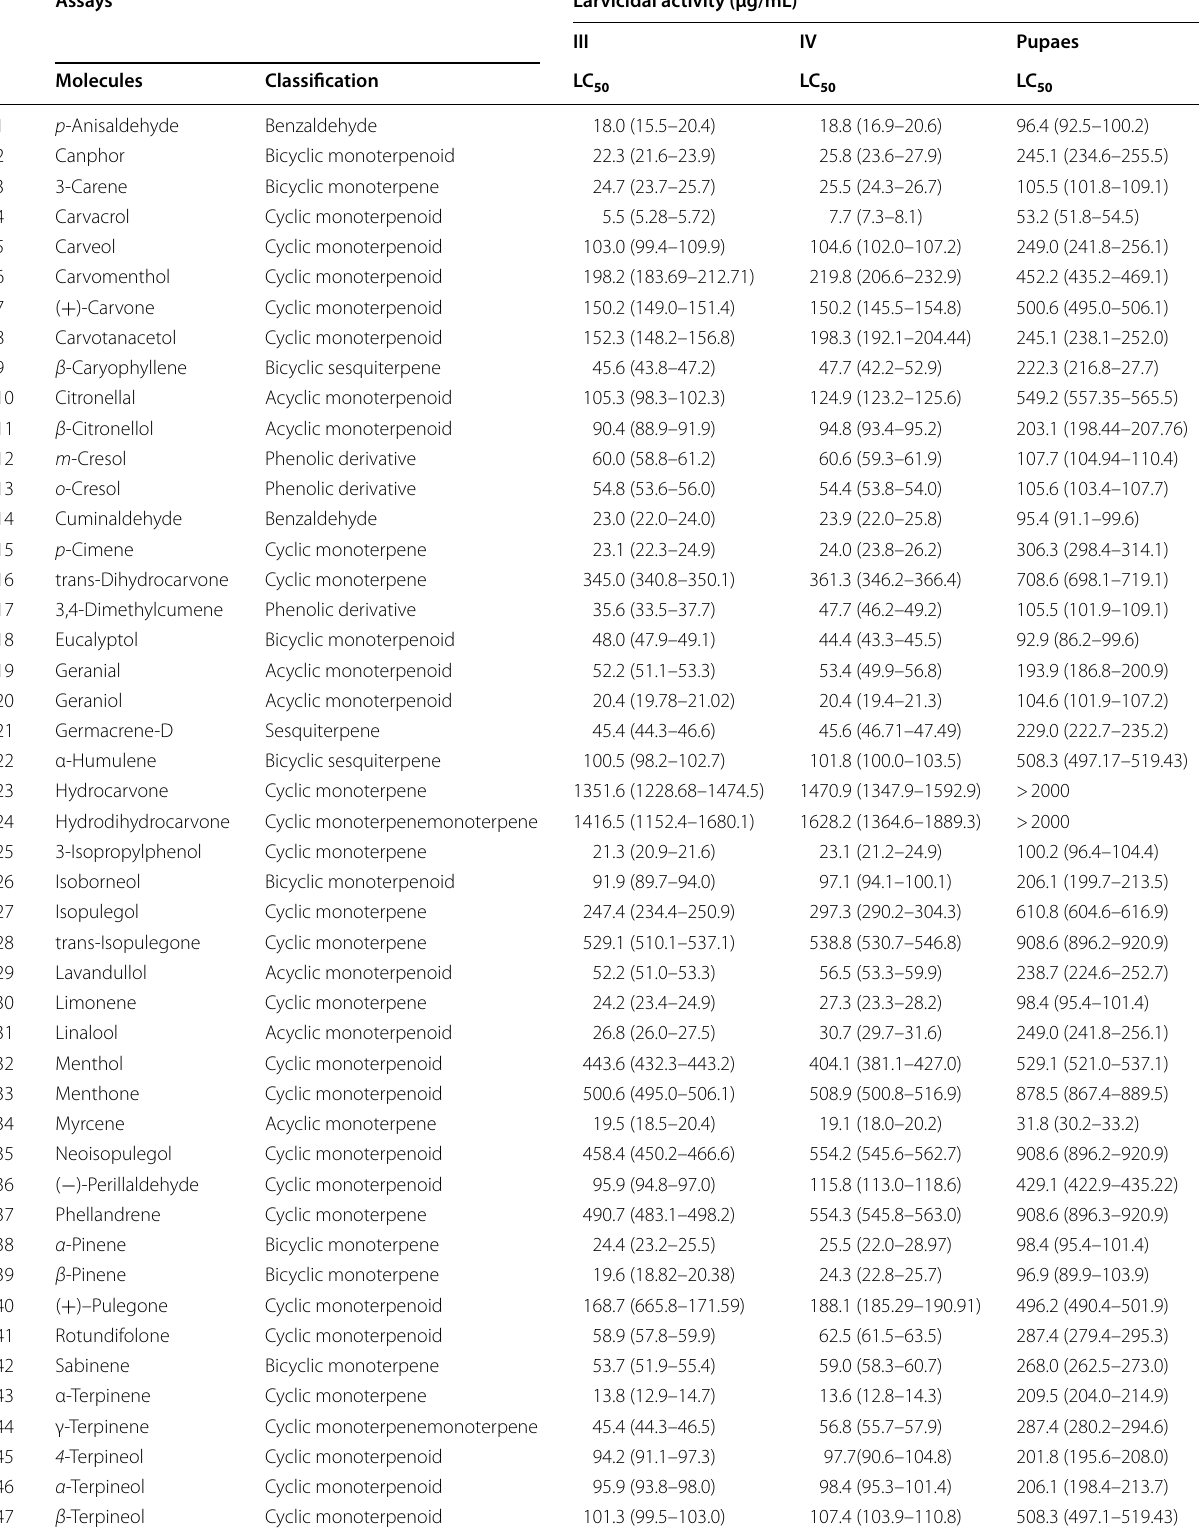
Table 1 Larvicidal activity of the terpenes, terpenoids and related compounds against Cx.